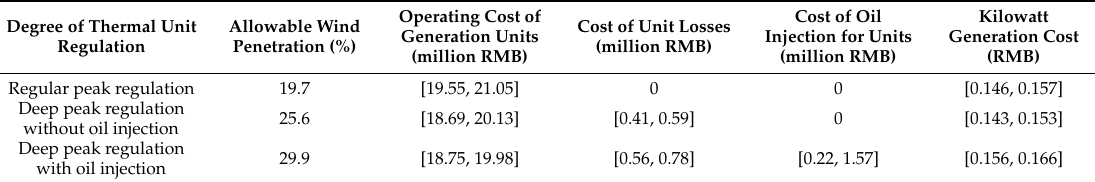
Table 6. Computation results based on concentrated integration.